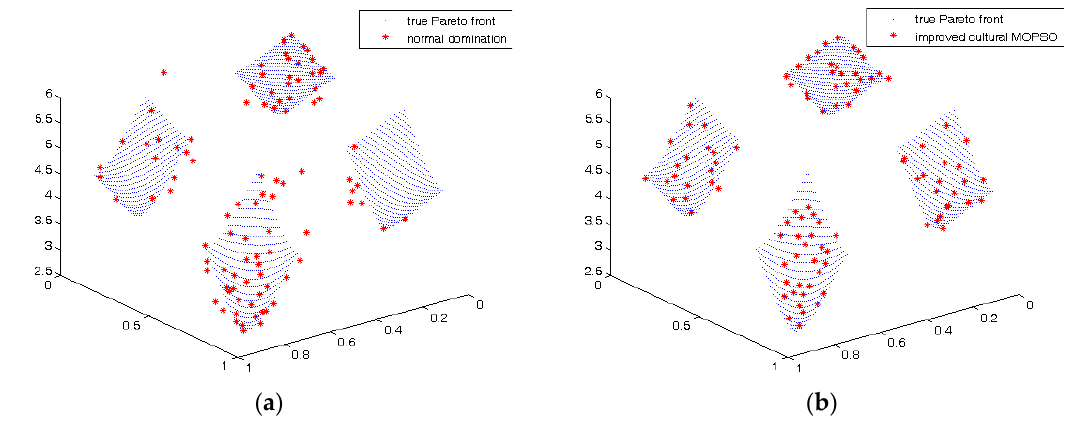
Figure 7. Pareto fronts for DTLZ7: ( a ) the Pareto fronts obtained using normal domination criterion; ( b ) the Pareto fronts obtained using hypercube-based ε -domination.